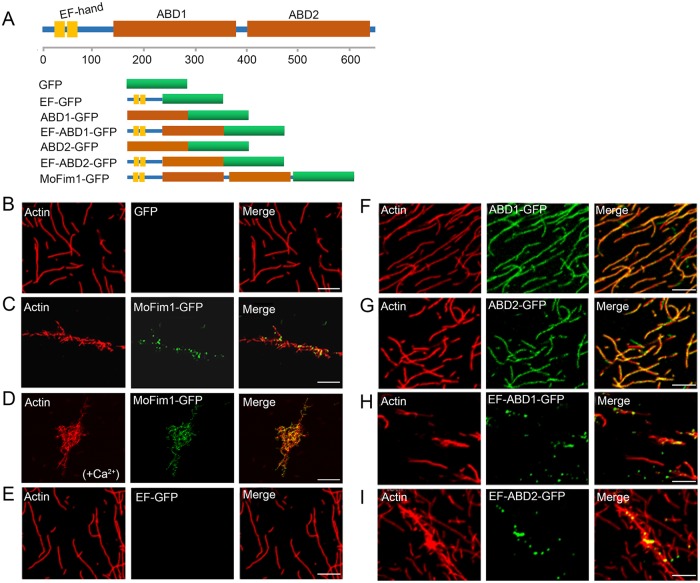
Biochemical analysis of MoFim1.(A) Schematic diagram showing the protein domains of MoFim1 and GFP-fused MoFim1 and truncated proteins. (B–I) Actin binding/bundling analysis of MoFim1 and its various domains by fluorescence observation. Polymerized F-actin (1 μM) incubated with various proteins (1 μM) was used for analysis. Alex561-phalloidin-labeled F-actin alone (B); F-actin in the presence of MoFim1-GFP (C); F-actin in the presence of MoFim1-GFP and Ca2+ (1 μM) (D); F-actin in the presence of EF-GFP (E); ABD1-GFP (F); ABD2-GFP (G); EF-ABD1-GFP (H) and EF-ABD2-GFP (I). Bars = 1 μm.